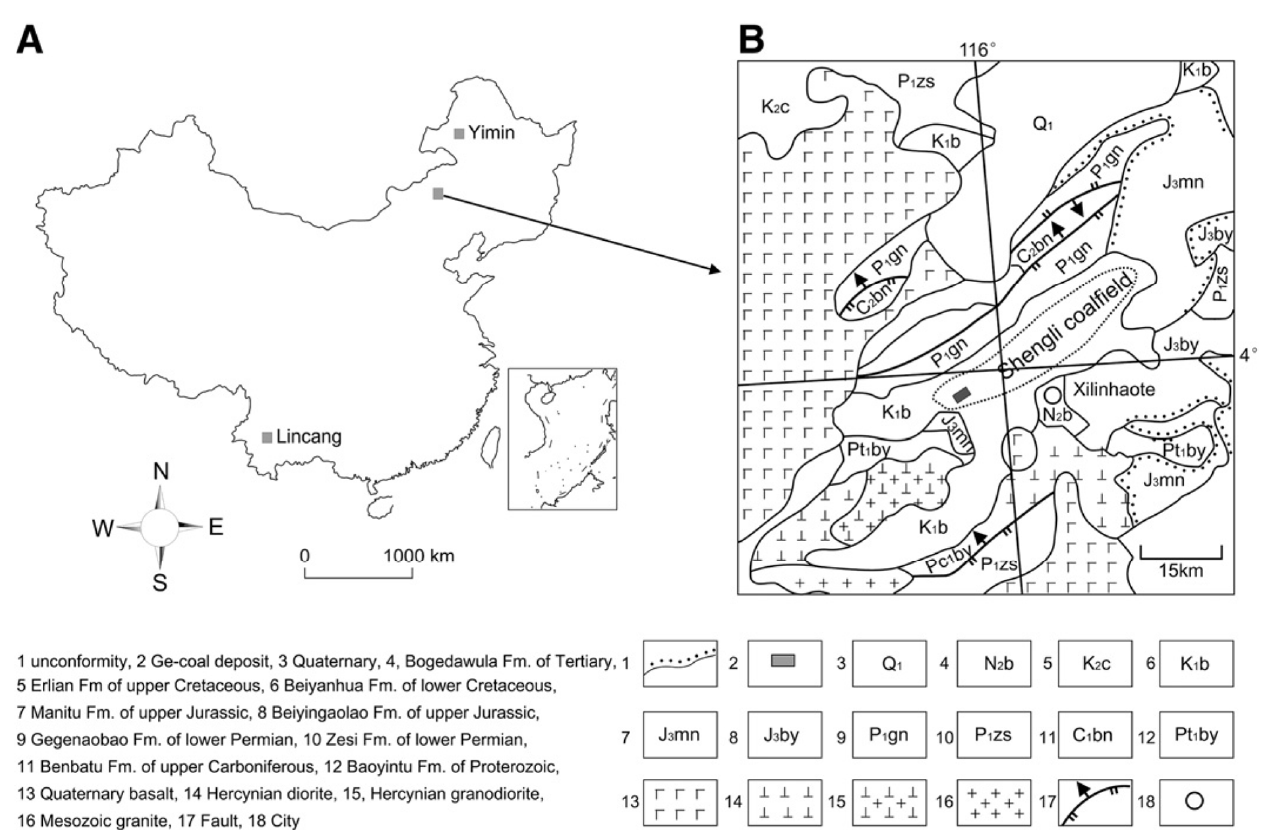
Figure 17. Location of the Shengli Coalfield and Wulantuga Ge ore deposit in Inner Mongolia, north- ern China. ( A ), location of the Shengli Coalfield; ( B ), geological background of the Shengli Coalfield.